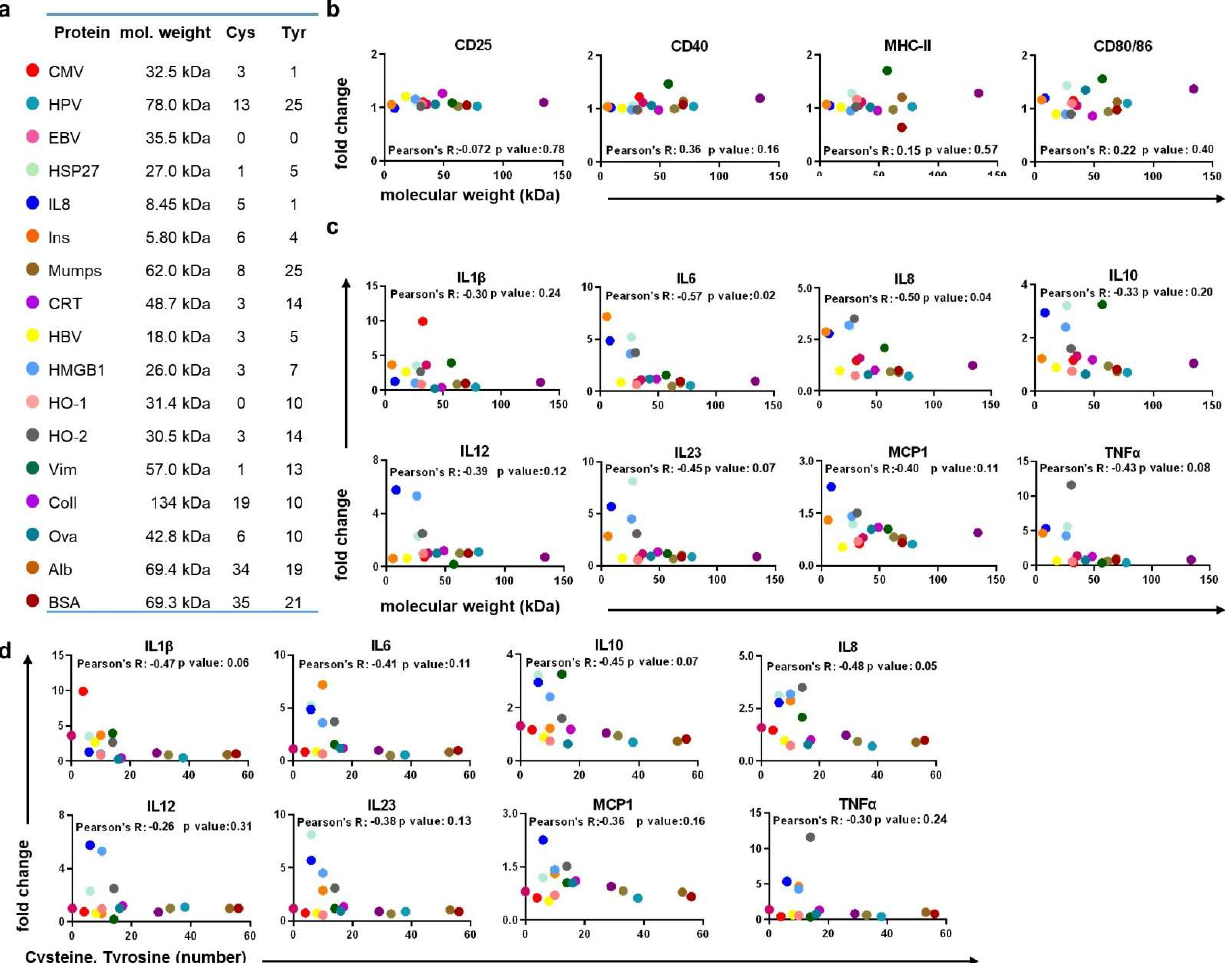
Figure A1. Correlation analysis between protein molecular weight and activation of myeloid-derived cells. ( a ) characteristics of proteins used in this study; ( b ) Pearson’s correlation between protein molecular weight (native; in kDa) and fold change expression of CD25, CD40, MHC-II, and CD80/86 on myeloid-derived cells after stimulation with oxidized proteins; ( c , d ) Pearson’s correlation between protein molecular weight (native; c ) and cysteine and tyrosine numbers ( d ) and fold change cytokine release after stimulation of myeloid-derived cells with oxidized proteins.